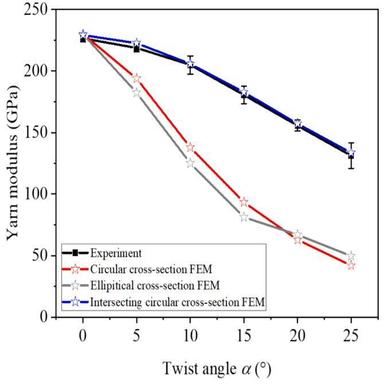
Comparison between experimental and numerical analysis results of the tensile modulus of carbon fiber tows.